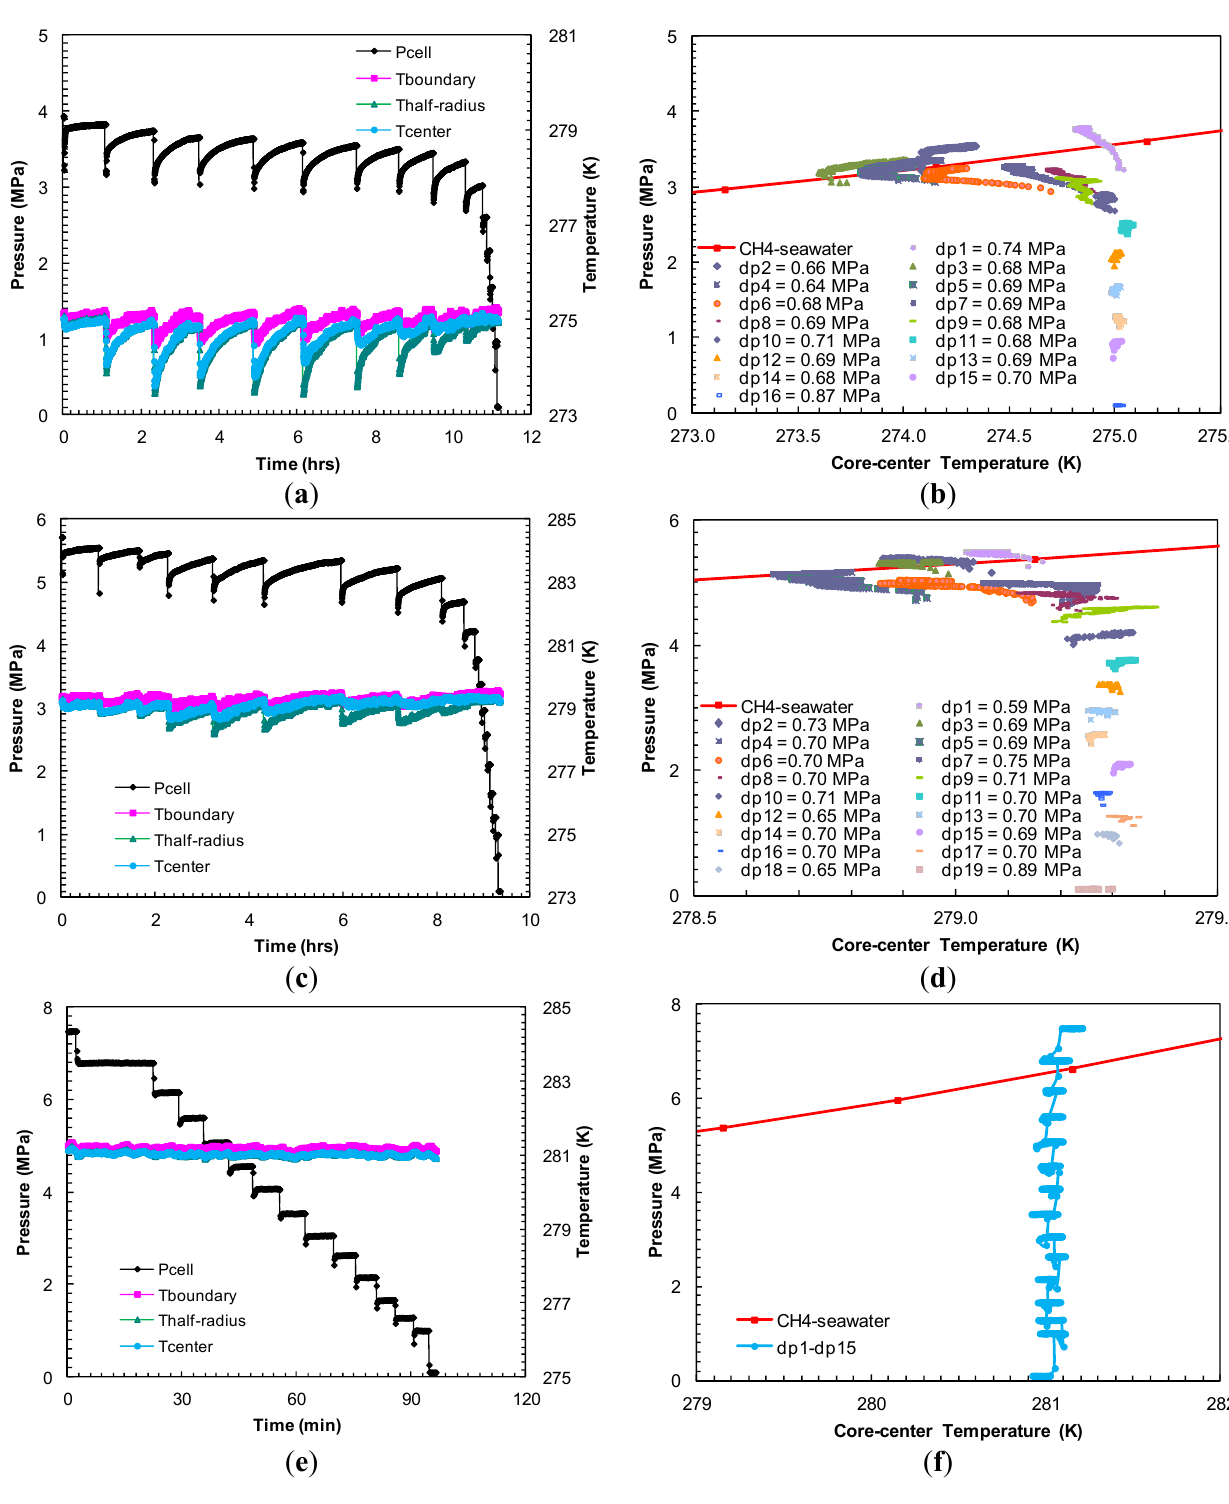
Figure 8. ( a , c , e ) Cell P - T against time during dissociation with sequences of pressure drop and thermally induced dissociation in Experiments 4–6; ( b , d , f ) Post-depressurization equilibrium pressure against temperature measured at the center of the sand-pack in Experiments 4–6. Each dataset corresponds to P - T conditions during thermally induced dissociations. Equilibrium conditions of methane hydrates-seawater were obtained from Duan and Sun